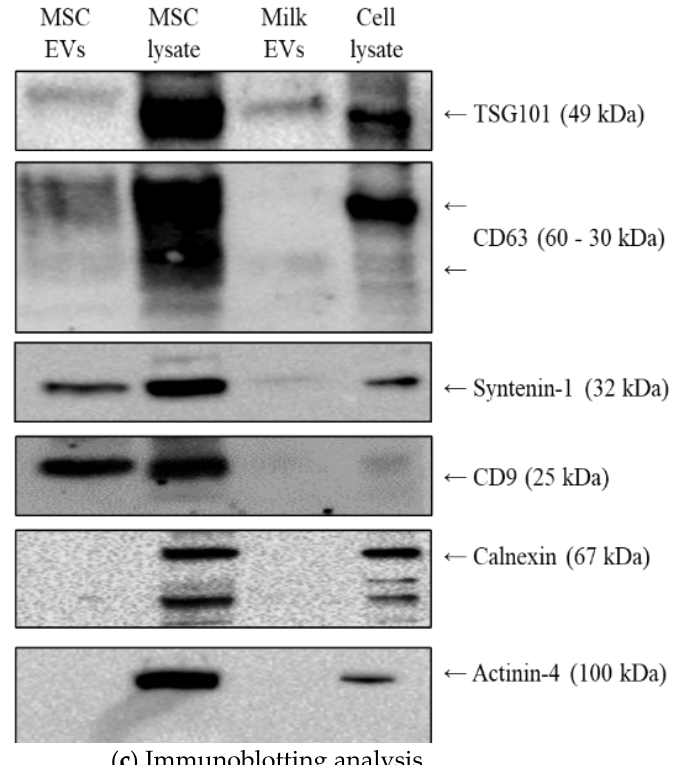
Figure 2. Fundamental characterisation of MSC EVs and milk EVs. MSC EVs and milk EVs ( a ) size distribution estimates obtained by NTA analysis and generated using NTA 3.1.54 software. ( b ) Rep- resentative TEM images (scale bar = 100 nm). ( c ) Immunoblots (using 20 µ g of EVs lysates or cell lysates) for TSG101, CD63, syntenin-1, CD9, calnexin, and actinin-4.